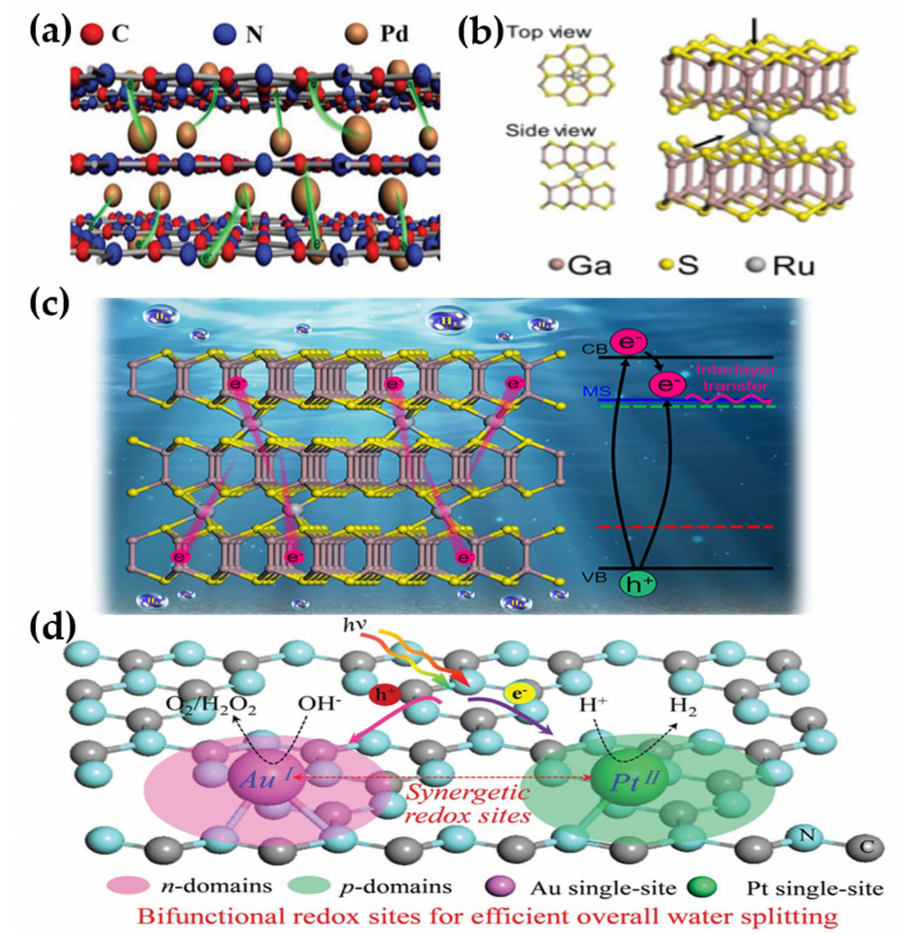
Figure 9. ( a ) Conceptual illustration of Pd/g-C 3 N 4 hybrid with the interlayer intercalation and surface anchor of Pd atoms [104]; ( b ) Structural model of the Ru − GaS NSs [40]; ( c ) Schematic diagram of photocatalytic HER over single- atom Ru(IV) intercalated GaS nanosheet [40]; and ( d ) Schematic of the solar-driven overall water splitting for synergetic bifunctional Pt–Au redox single sites